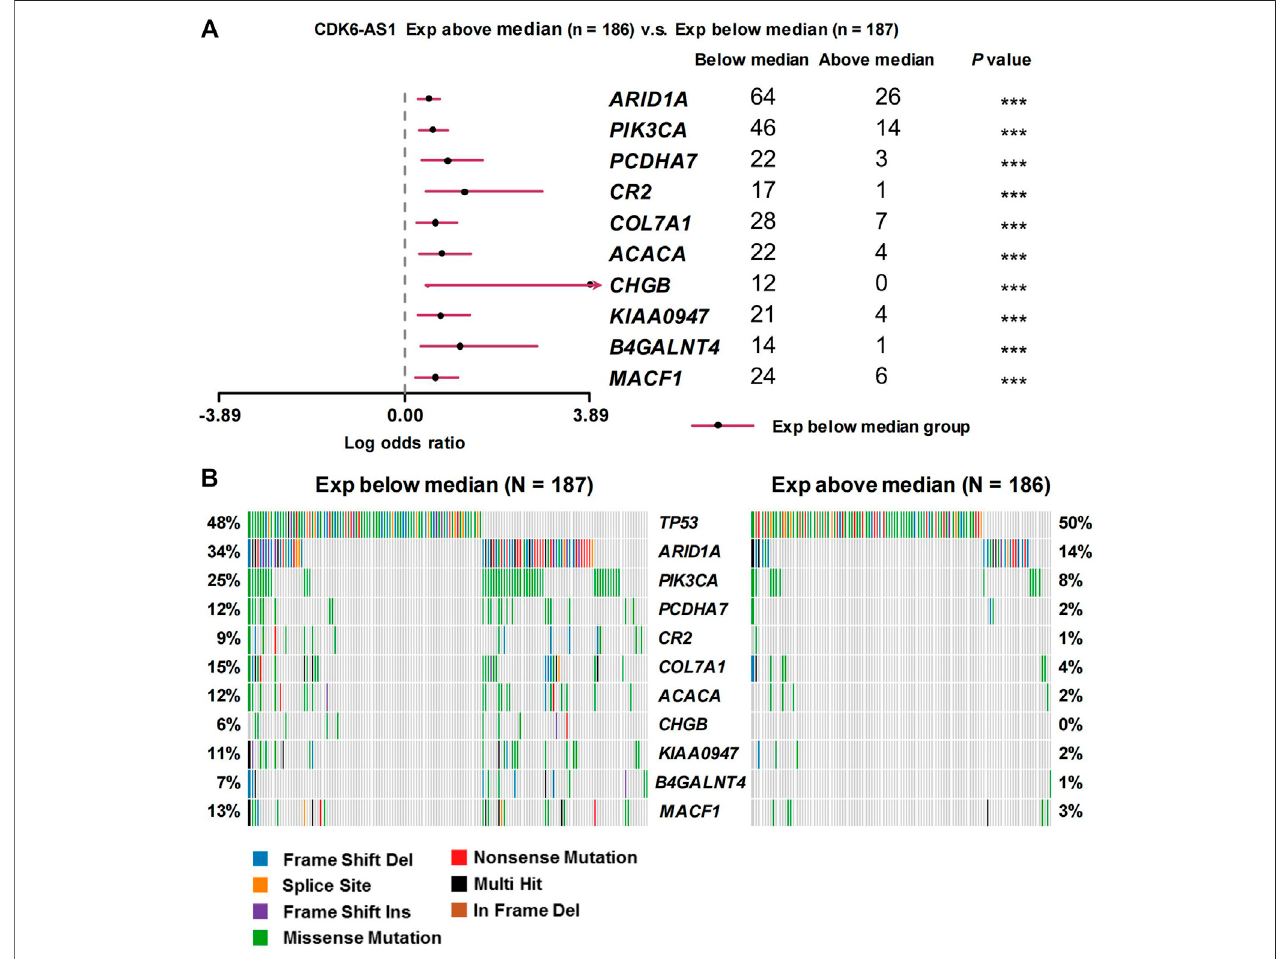
FIGURE 3 | Frequencies of mutated genes between different CDK6-AS1 expression group. (A) Forest plot showing the top frequencies of mutated genes in the high- and low- CDK6-AS1 expression groups. (B) Waterfall plot side by side for comparison of different mutated genes and mutated types between the high- and low- CDK6-AS1 expression